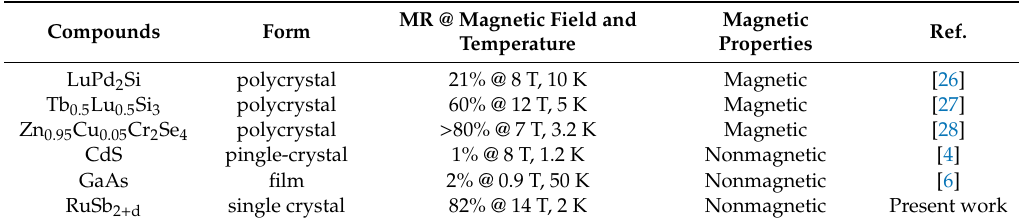
Figure 3. ( a ) The transversal MR measured with the current I on the ab plane and the magnetic field H out of the ab plane at 2, 10, 20, 35, 50, 100, 200, and 300 K; ( b ) the longitudinal MR with both I and H in the same direction on the ab plane; and ( c ) the transversal MR measured on the ac plane. Table 1. Comparison of the MR observed in RuSb 2 and other semiconductors.